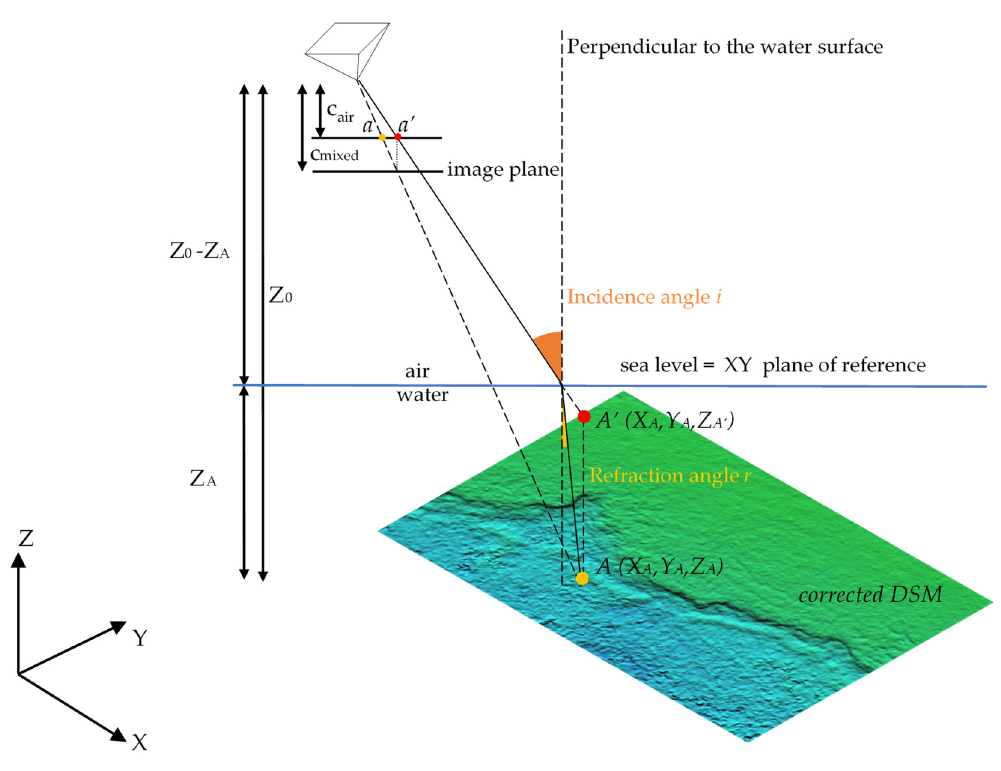
Figure 6. The geometry of a single image formation and the repositioning of an image point based on the calculated focal length (c mixed ).